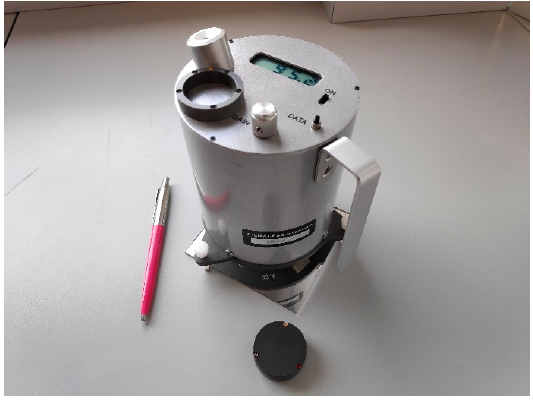
Figure 2. Portable specular reflectometer 15R-USB by Devices and Services (D&S).